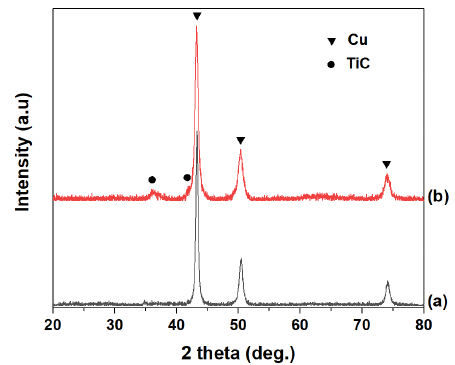
Figure 3. X-ray diffraction (XRD) pattern of as-milled powders ( a ) Cu-TiH2-C with 5 vol. % TiC and ( b ) Cu-TiC with 5 vol. % TiC.